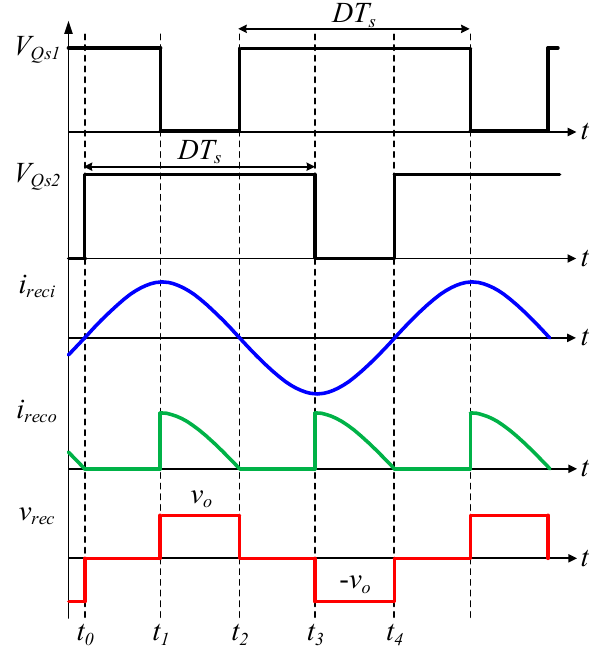
Figure 3. Key waveforms of double-sided LCC compensation topology with S-BAR.